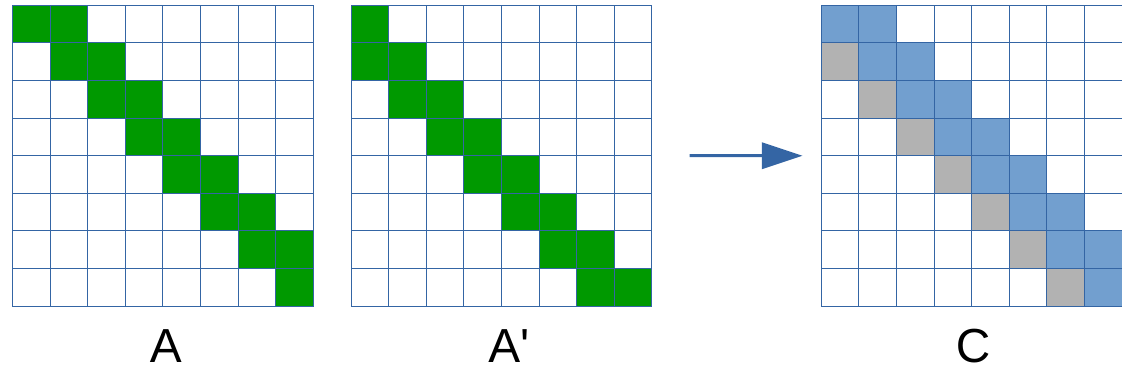
Figure 4. Matrix product of A · A (cid:48) , with A upper-diagonal. Green = cells used in computation, blue = cells to be computed, grey = duplicated cells.